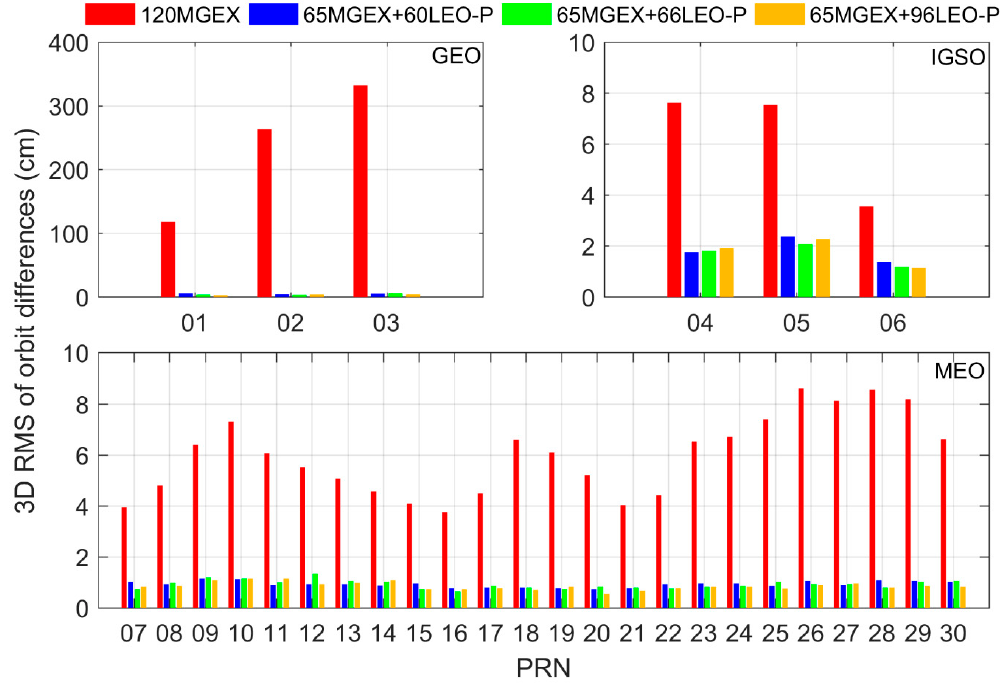
Figure 6. Average 3D RMS values of BDS orbit differences for the integrated POD with different numbers of LEO satellites.